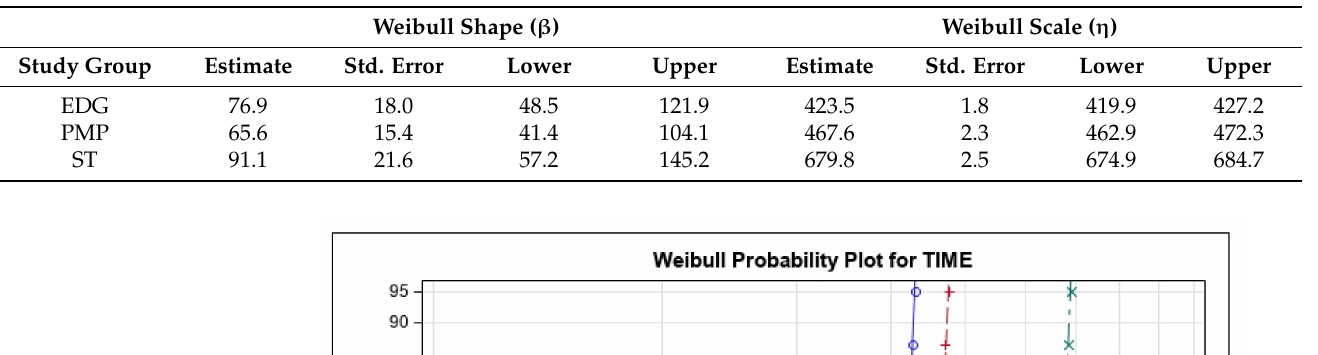
Table 5. Weibull statistics of time to failure for the EDG, PMP, and ST novel brands of NiTi alloy endodontic files.